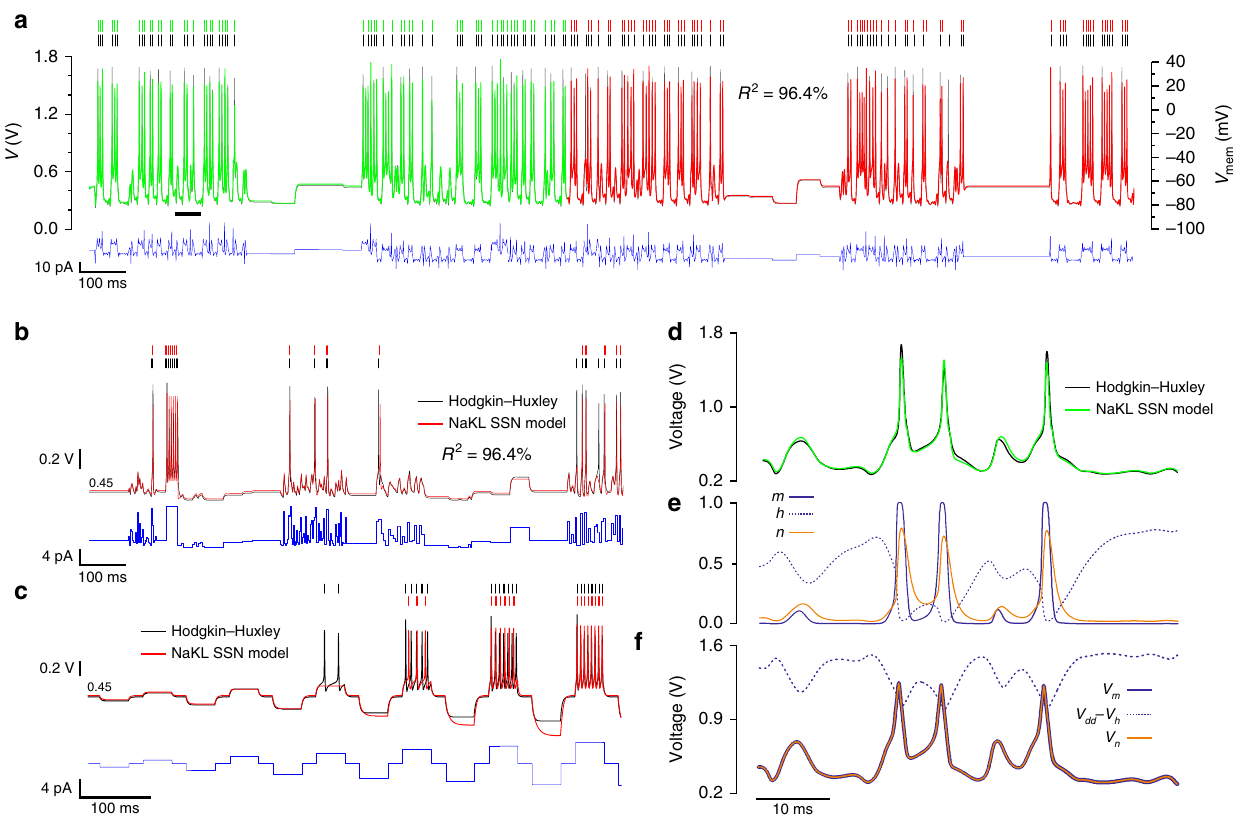
Fig. 3 Equivalence of the NaKL SSN model and the Hodgkin – Huxley model. a The equivalence between the two models is demonstrated by synchronizing the SSN model to membrane voltage oscillations synthesized by the Hodgkin – Huxley model (black line). The Hodgkin – Huxley time series voltage was assimilated over a 1000-ms-long window (green line) under the constraints of the current injection protocol (blue line). The membrane voltage was predicted from t = 1000 ms onwards by forward integrating the current protocol with the completed SSN model (red line). b , c Membrane voltages predicted by the same SSN model (red line) and HH model (black line) for two different current protocols. d Detail of the SSN and HH action potentials and a comparison of NaT and K gate variables in e the HH model and f the SSN